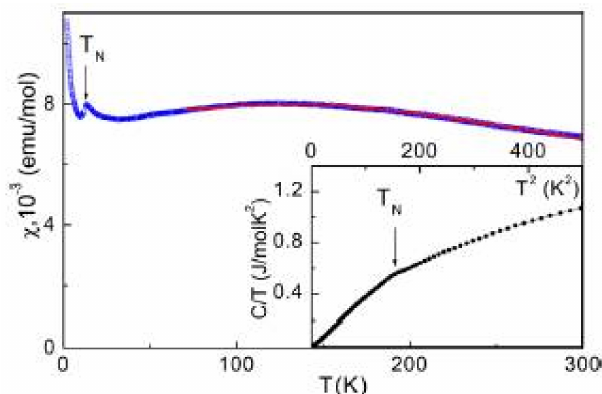
Figure 12. Temperature dependence of magnetic susceptibility in Bi 2 Fe(SeO 3 ) 2 OCl 3 . The solid line represents the fit in a Heisenberg S = ∞ antiferromagnetic chain model. The inset represents the temperature dependence of specific heat on the C/T vs. T 2 scale. Reprinted with permission from [30] Copyright (2014) American Chemical Society.